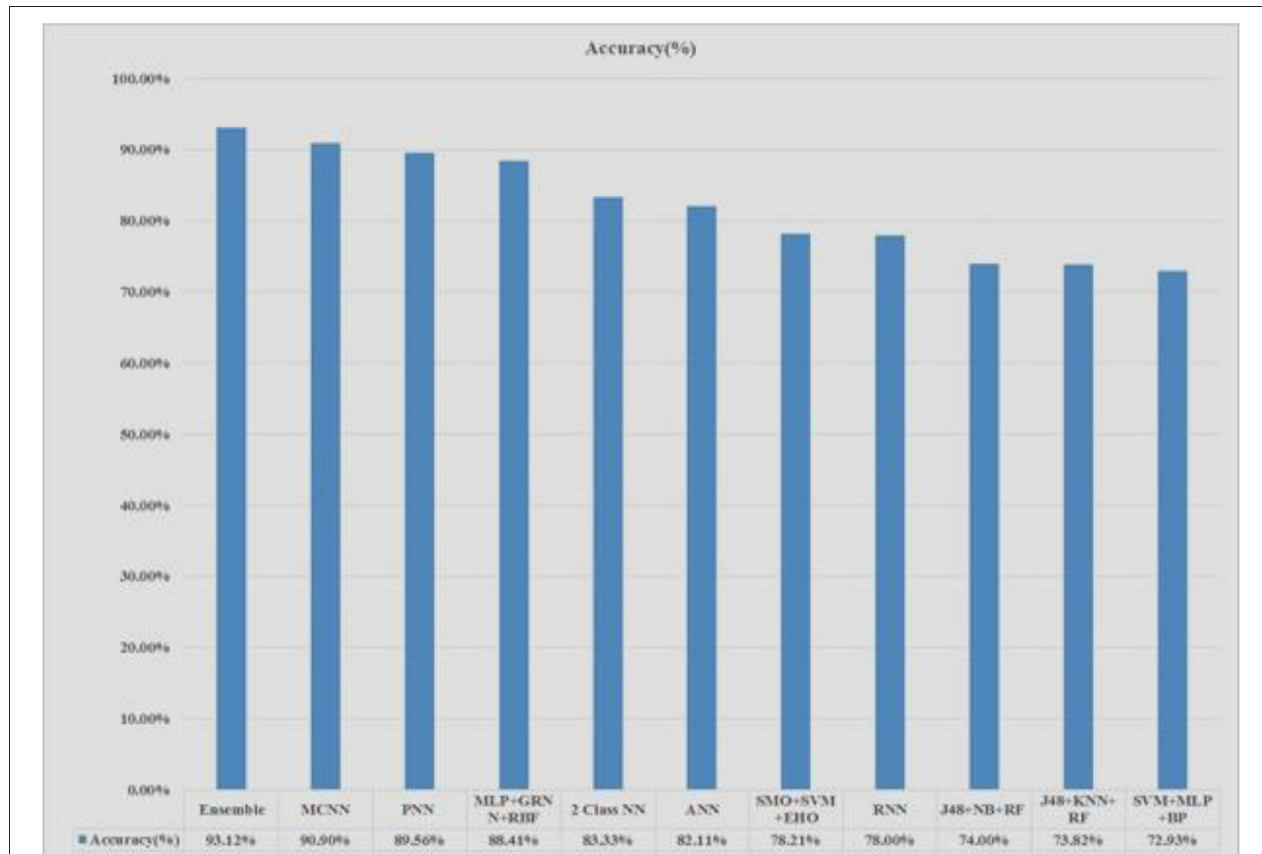
FIGURE 8 | Accuracy chart of various models and proposed model comparison chart. classification. Equations 7 and 8 are used for computing classification output.